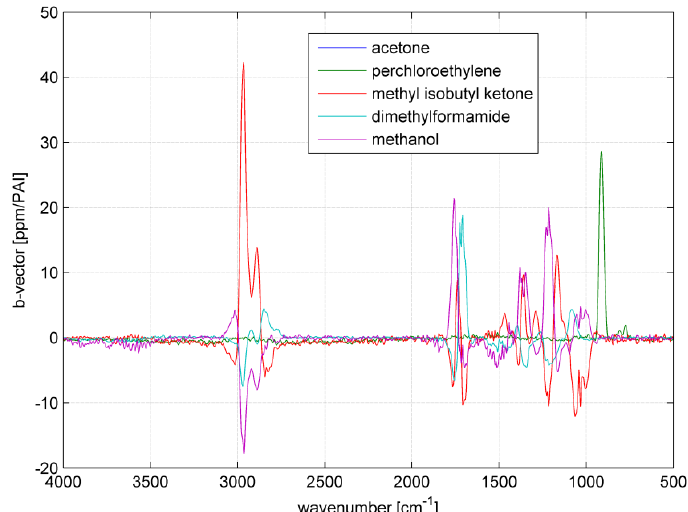
Figure 6. Selectivity experiment: b-vectors of the five